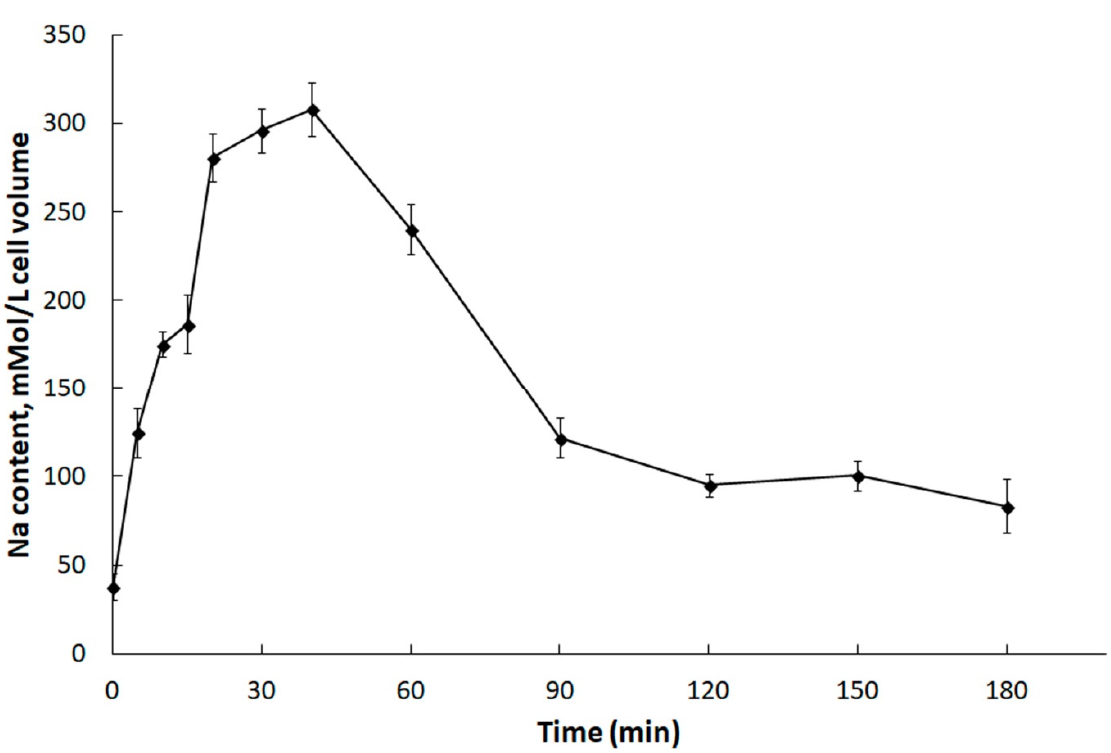
Figure 5. Changes in concentrations of Na + ions in D. maritima cells under hyperosmotic salt shock. The alga was grown in a medium containing 0.1 M NaCl. At “zero” time, the salt concentration in the cell suspension was increased to 0.5 M. Each point on the graph is the average of 4 analytical replications. The abscissa axis indicates the incubation time of algal cells in hypertonic salt medium.